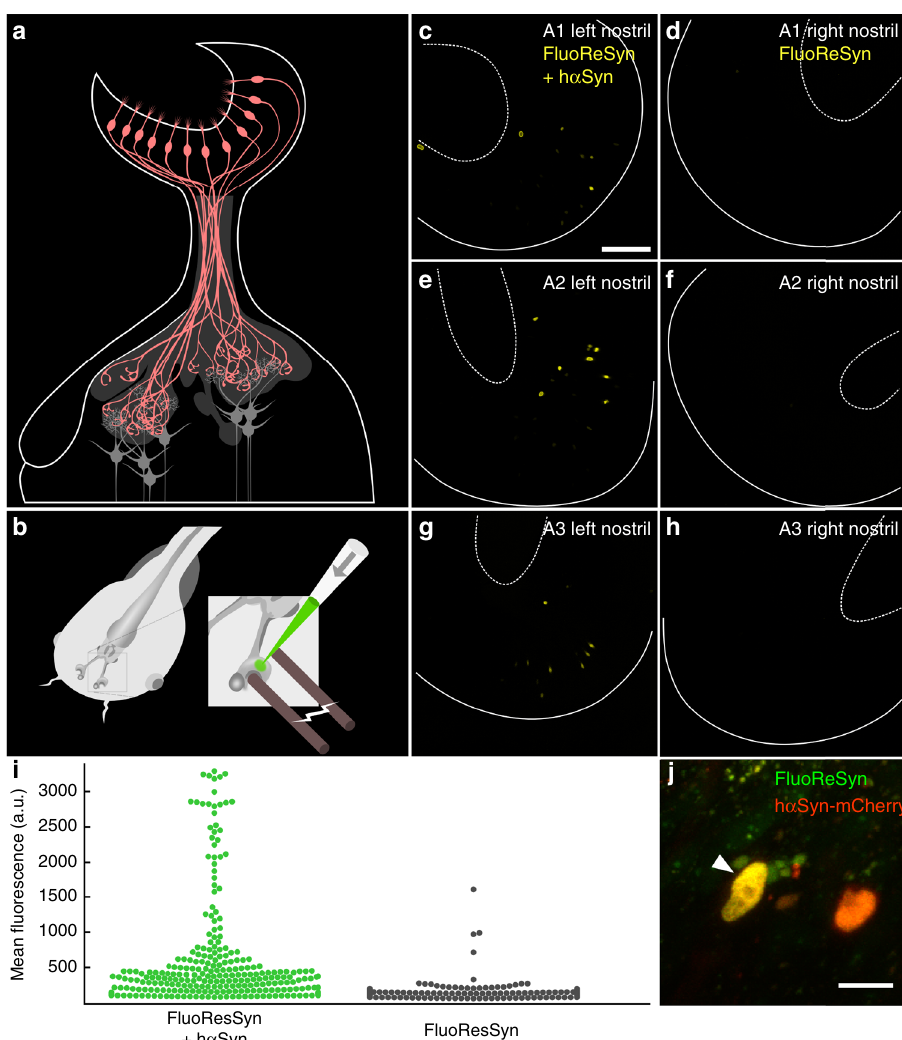
Fig. 3 in vivo FluoReSyn activity in neurons of larval Xenopus laevis . a Organization of the Xenopus laevis olfactory system: olfactory receptor neurons (ORNs; red) residing in the olfactory epithelium project their axons to the olfactory bulb, where they synapse onto the second order projection neurons (gray). b Schematic of plasmid electroporation into the olfactory mucosa of anaesthetized Xenopus laevis tadpoles. c , e , g Left nostrils of three animals (A1 – A3) were co-electroporated with FluoReSyn- and h α Syn-expressing plasmid. Scale bar represents 100 µ m. d , f , h Respective right nostrils electroporated only with FluoReSyn. For all animals and nostrils identical plasmid concentrations and imaging settings were used. Basal and apical delineations of olfactory epithelium are indicated by line and dashed line, respectively. i Distribution of FluoReSyn mean fl uorescence intensity of positive nuclei from the left nostrils (FluoReSyn and h α Syn plasmid; green dots) and nuclei from the right nostrils (FluoReSyn plasmid only; black dots) in arbitrary units (a.u.). More than 500 nuclei were analyzed from nine animals ( n = 9) imaged in vivo. Unpaired and two tailed student t test results in p < 0.0001 (****). j High magni fi cation example of a neuron co-expressing FluoReSyn (green) and h α Syn-mCherry (red), resulting in nuclear colocalization (yellow) of both proteins. Scale bar represents 10 µ m. Source data is available as a Source data fi